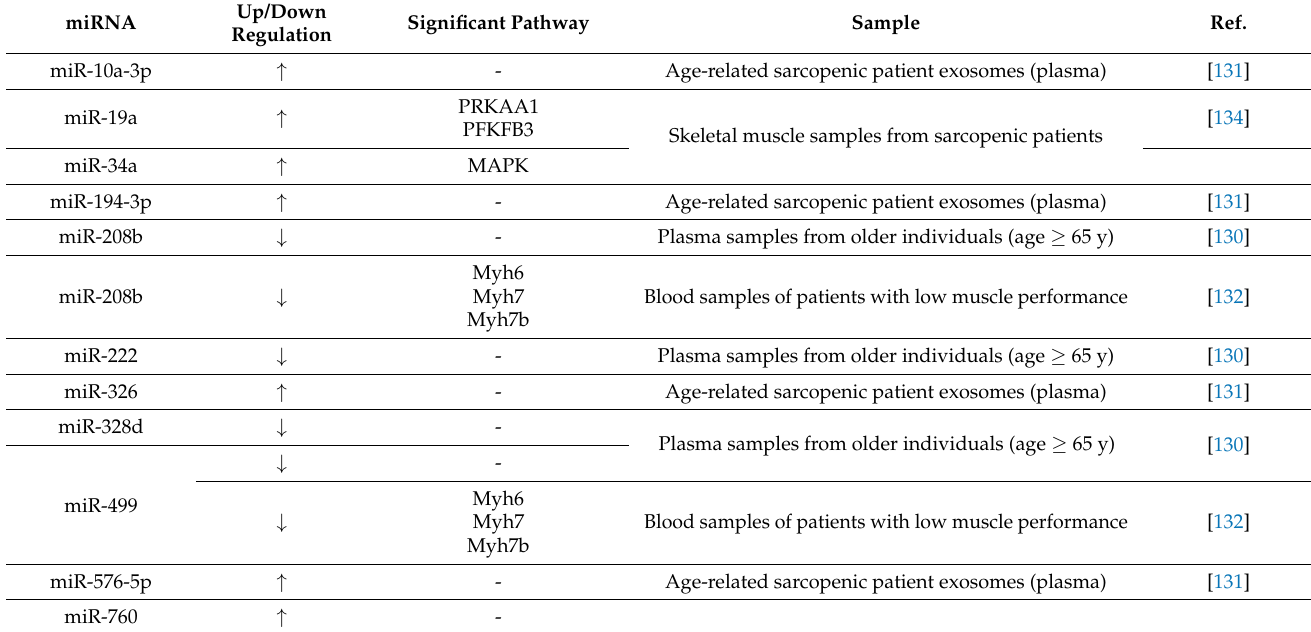
Table 2. Sarcopenia—Exclusive miRNAs dysregulated in sarcopenic patients.